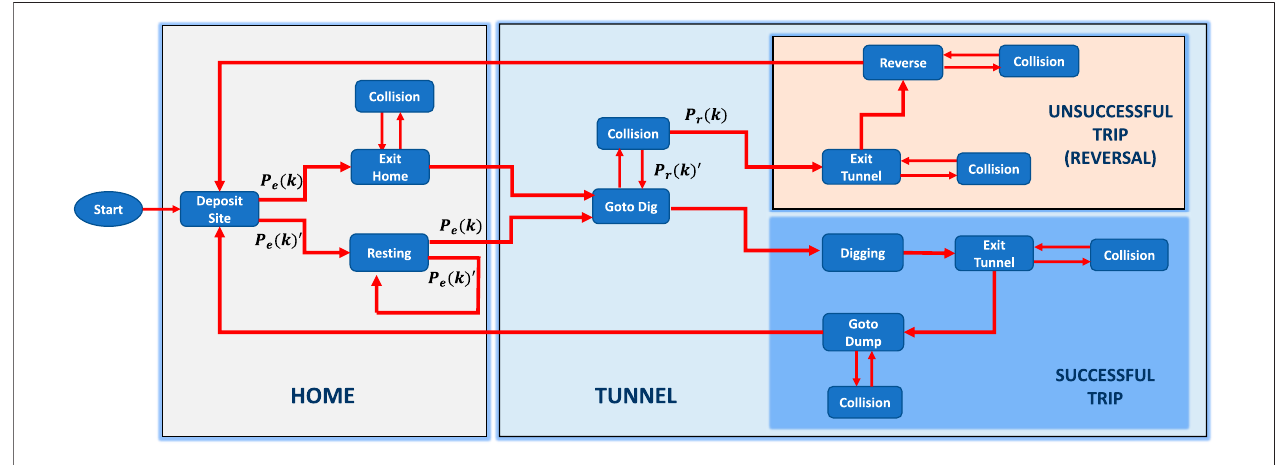
FIGURE2| Blockdiagramfortheindividualrobot controller.Statetransitionsareevent-based. P e :probabilityoftunnelentry(orgotodig). P e ′ :probabilityofresting (or staying at home). P r : probability of “ giving up ” after colliding with another robot in the tunnel. P r ′ : probability of continuing to dig after colliding with anther robot.